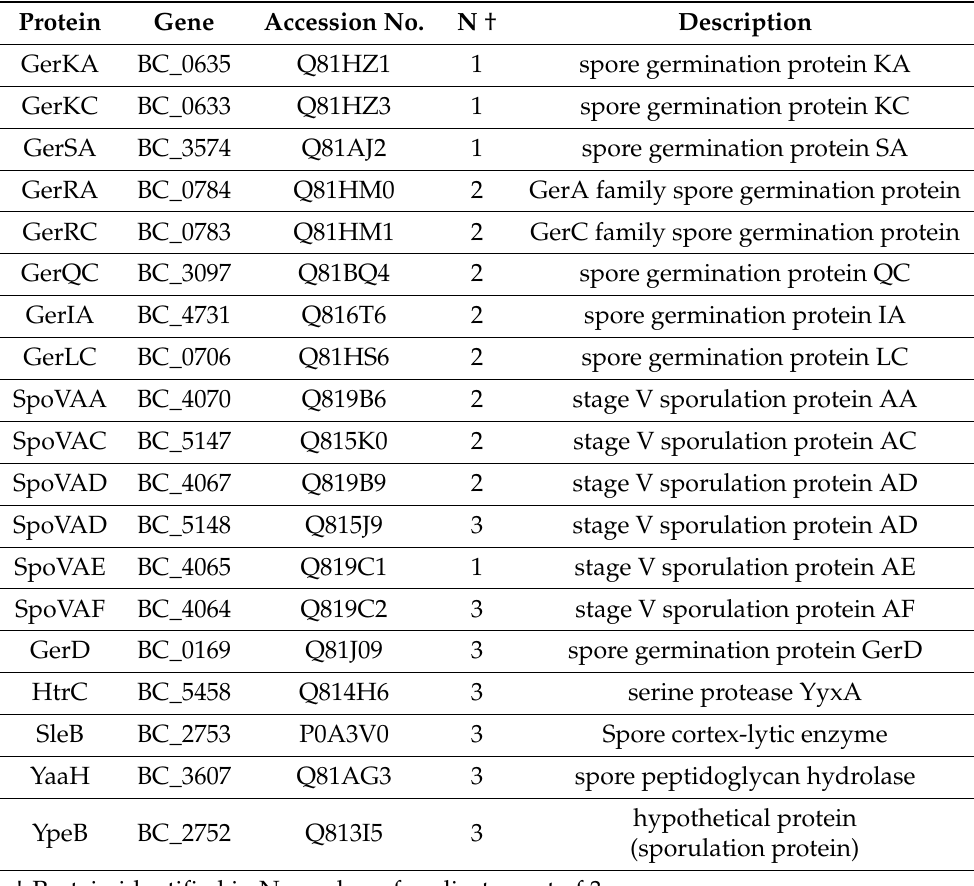
Table 1. Germination associated proteins identified in this